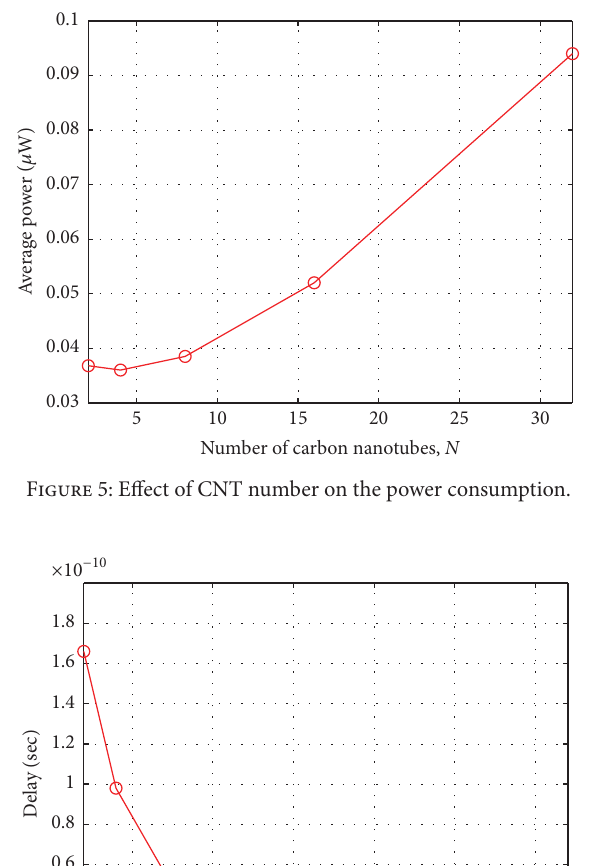
Table1:NominalCNTFETparametersusedforHSPICEsimulation [8].